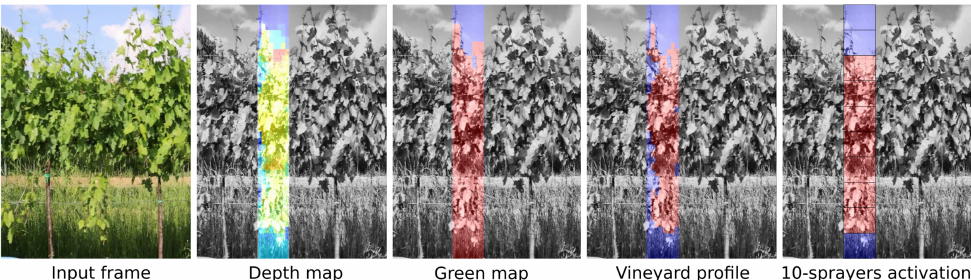
Figure 16. Example frame and respective maps (limited to the ROI covered by the sprayer) of qualitative analysis on video captured in